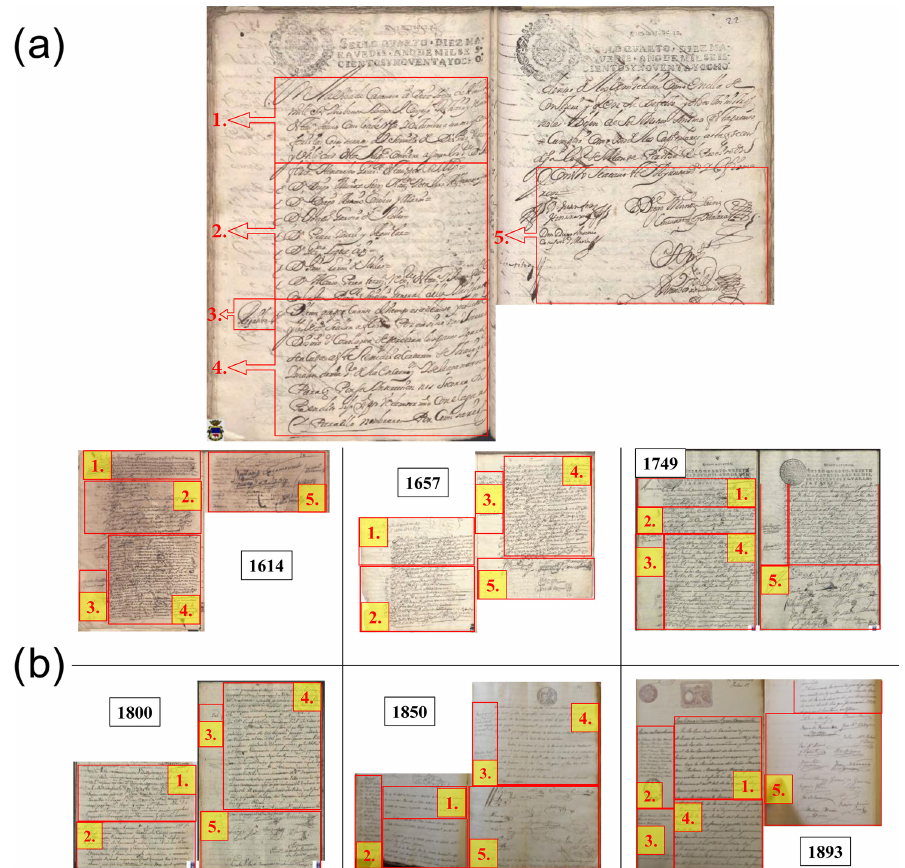
Figure 2. The Caravaca CCO meeting sample (18 April 1698) (a) and different examples of MCA throughout the study period (b) . The main parts of a MCA are marked: 1 – date, place and type of meeting (ordinary or extraordinary); 2 – full name of those attending the meeting; 3 – short summary of the topics discussed; 4 – topic memorandum and attendees’ contributions; 5 – attendees’ signatures. Note: the text in panel (a) describes a ceremony to ask God for rain (pro pluvia): “Dijeron que por cuanto el tiempo es adelante y no llueve y los vecinos se hallan afligidos, porque si no nos socorre Dios mío con el agua se perderán los panes y para que se acuda a este remedio acordaron se